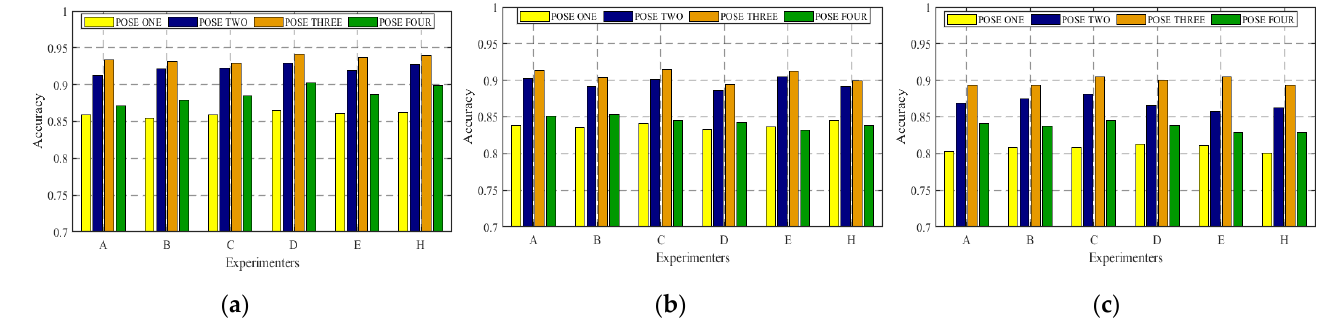
Figure 11. Recognition rate of different people practicing different actions in different experimental scenes. ( a ) Yoga classroom; ( b ) laboratory; ( c ) dormitory.